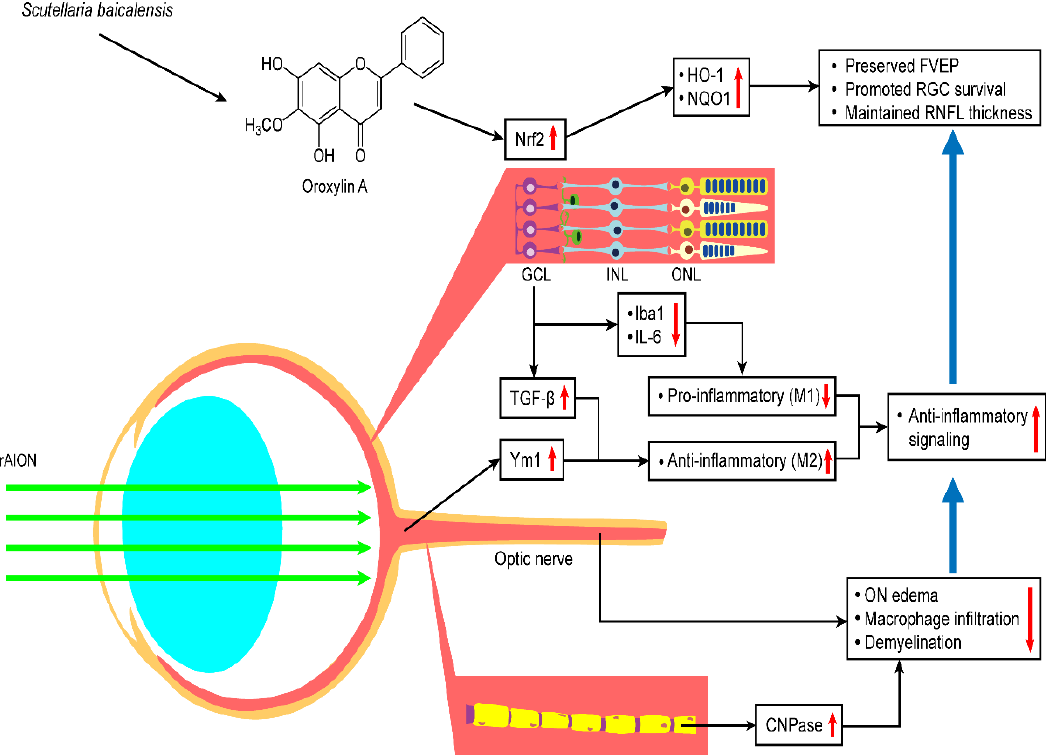
Figure 11. Hypothetical model of the protective effects of OA in the rAION model. OA treatment after rAION induction can enhance Nrf2 pathway activation and thereby preserve FVEP, promote RGC survival, and maintain RNFL thickness. OA also shows anti-inflammatory effects and modulates microglia polarization by increasing TGF-b and Ym-1 expression and decreasing Iba1 and IL-6 expression. OA protects the optic nerve by reducing ON edema, macrophage infiltration, and demyelination.